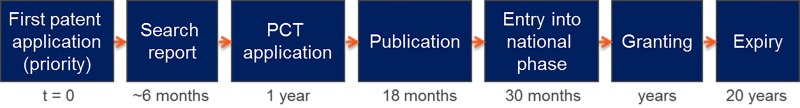
Typical patent timeline from application until expiry (20 years from the filing date of the PCT application).